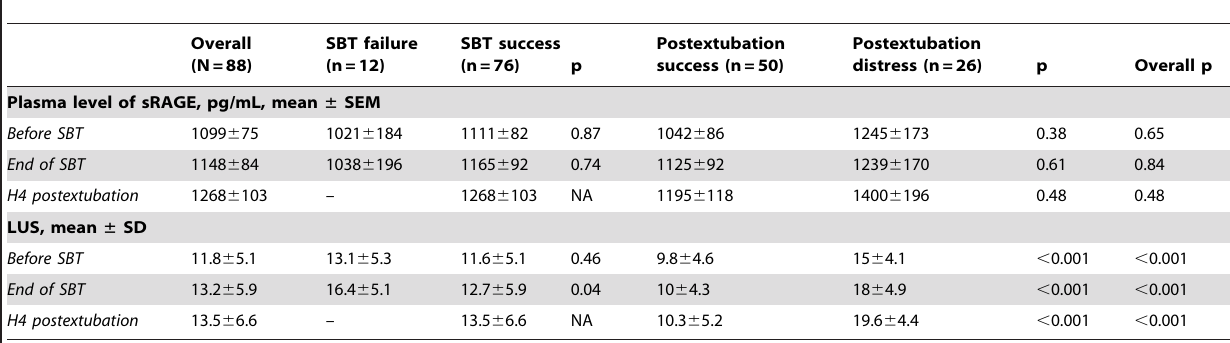
Table 2. Spontaneous breathing trial-induced changes in plasma levels of sRAGE and lung ultrasound score.